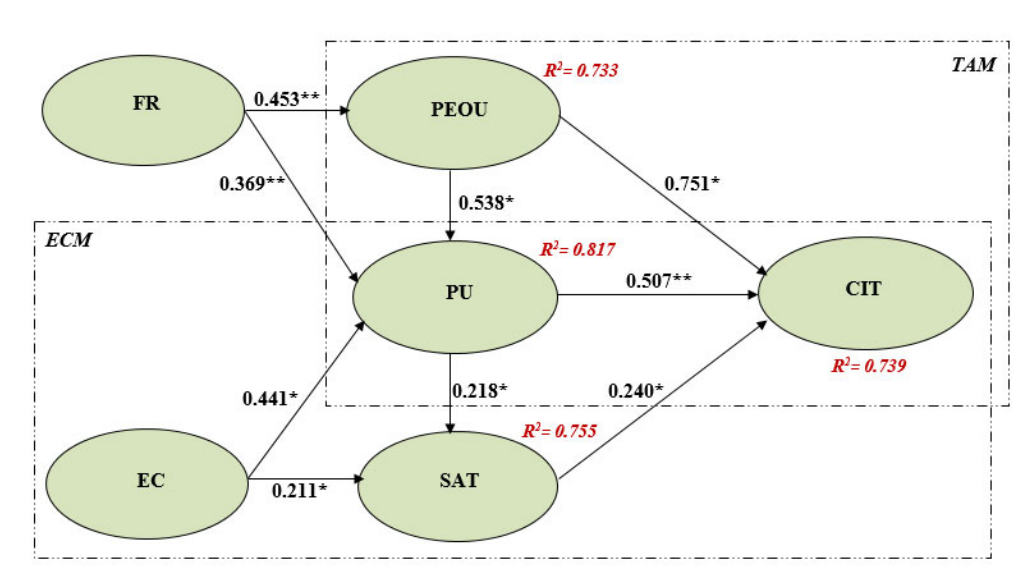
Fig. 2. Hypotheses testing results (significant at p** < = 0.01, p* <